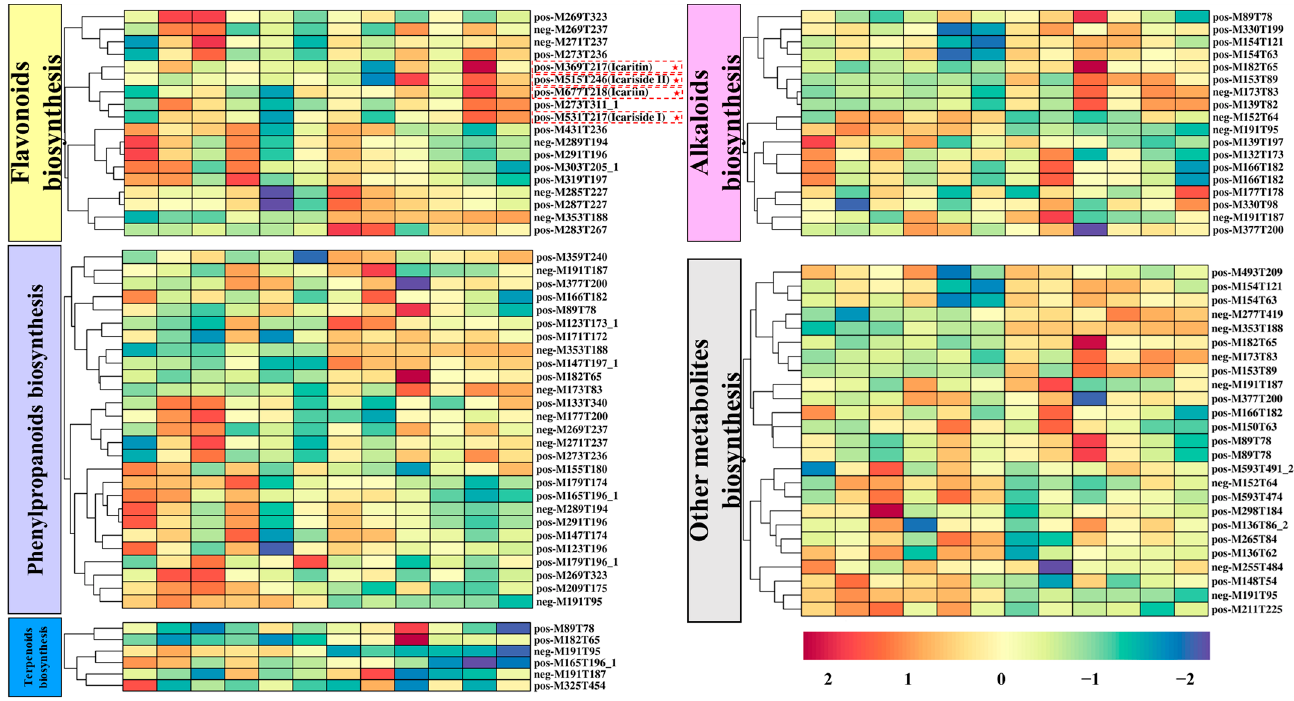
Figure 8. A heatmap of the relative amounts of flavonoids, phenylpropanoids, terpenoids, alkaloids, and other metabolites biosynthesis in E. sagittatum leaves. and other metabolites biosynthesis in E. sagittatum